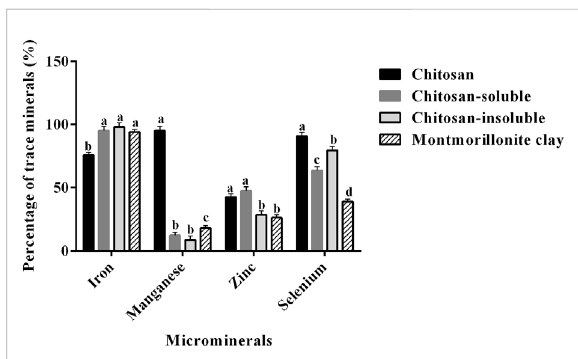
FIGURE 7 Percentage of adsorption of trace minerals for chitosan, chitosan-soluble, and chitosan-insoluble, and montmorillonite clay in an in vitro gastrointestinal poultry model. Different